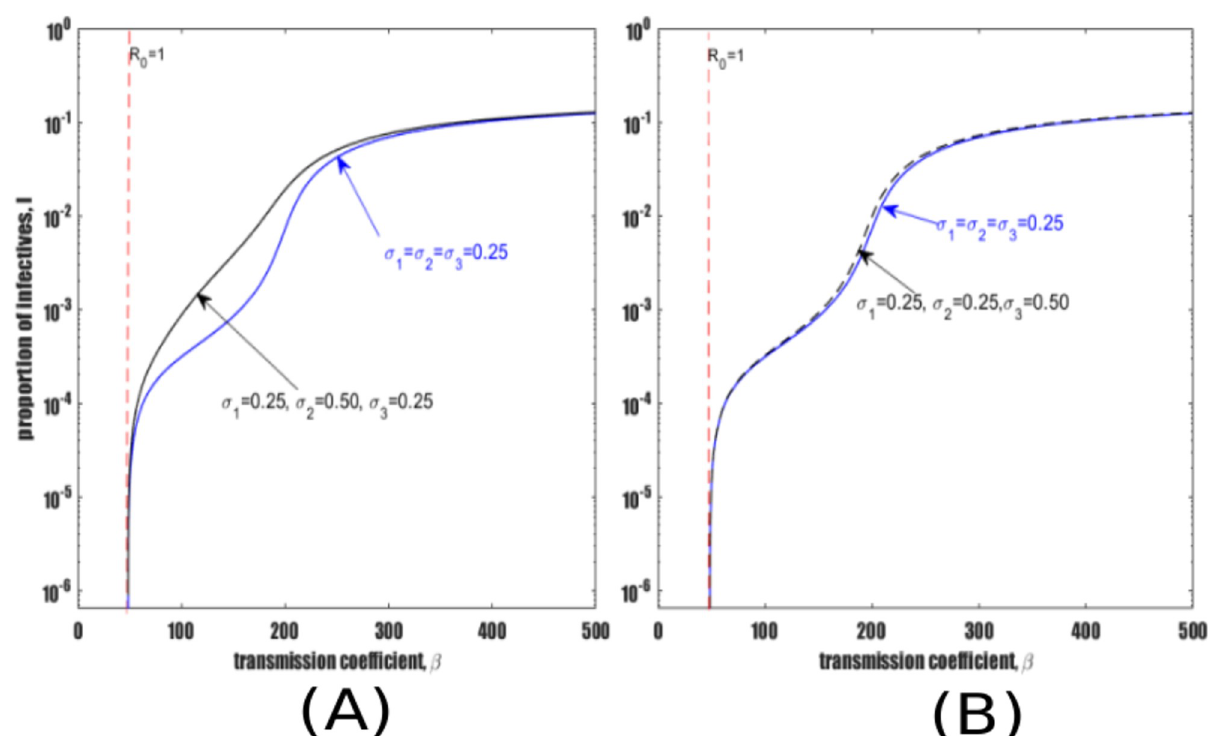
Fig 3. Illustration of the relative importance of σ 2 and σ 3 to equilibrium dynamics. Parameters as in Table 1. Reference homogeneous model σ 1 = σ 2 = σ 3 . (A) Impact of increasing σ 2 . (B) Impact of increasing σ 3 .